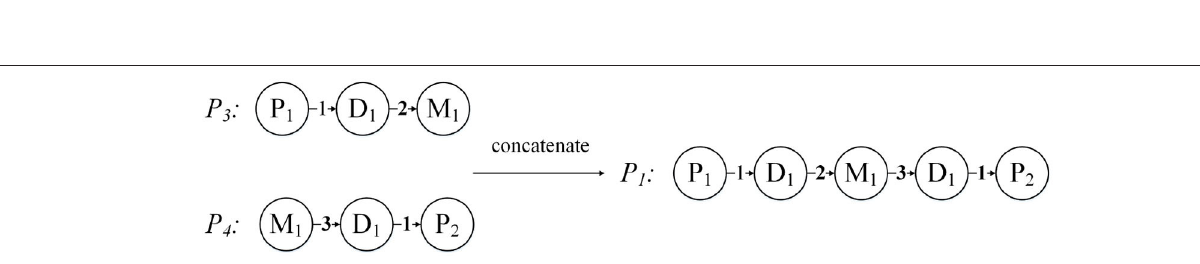
FIGURE 6 | Concatenation of weighted meta